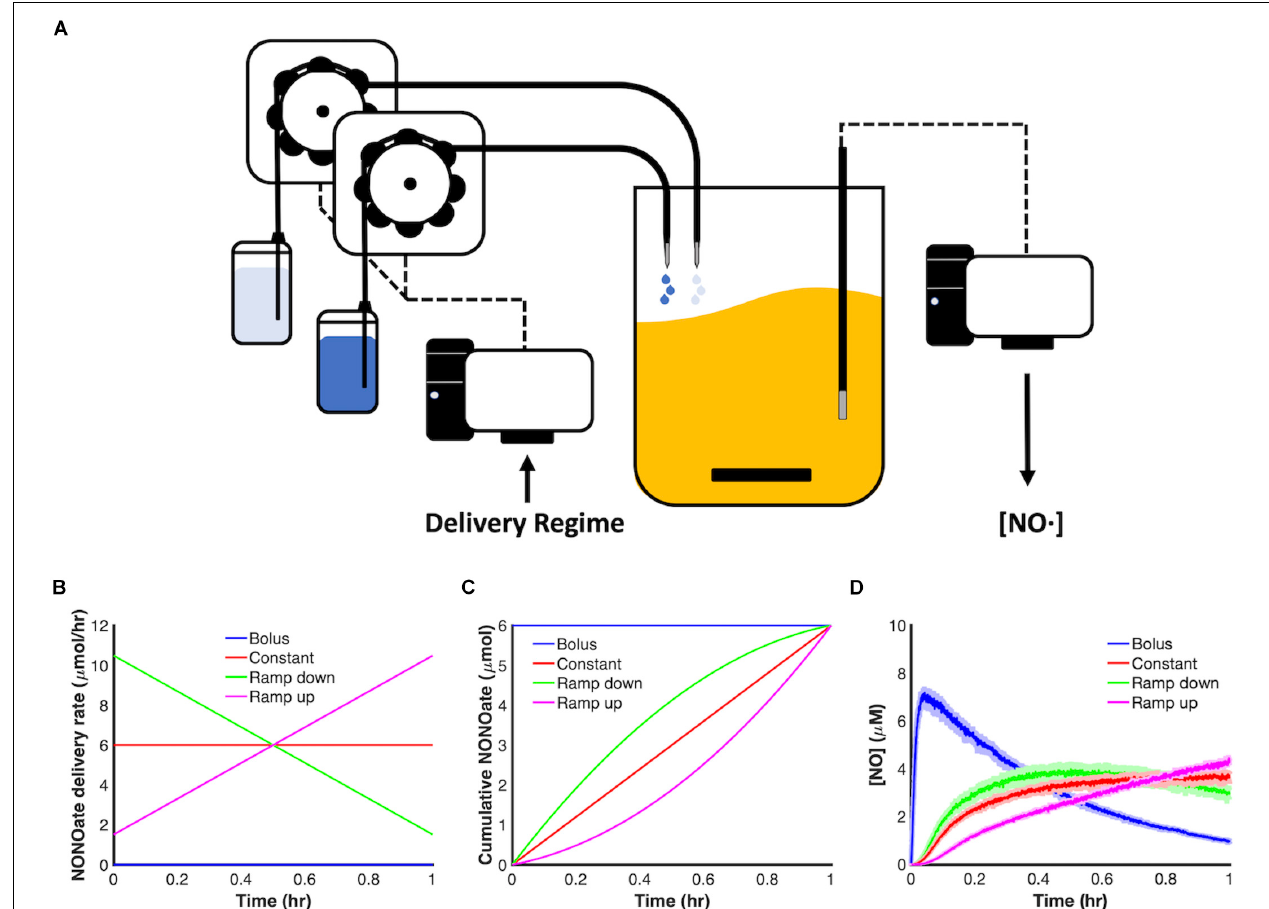
FIGURE 1 | Control of NONOate delivery dynamics. (A) Schematic of a computer-controlled, fed-batch bioreactor used to deliver NONOate. Delivery schedules were programmed using a computer-controlled low flow drip system. Once initiated, individual peristaltic pumps drew solutions from two reservoirs: PAPA NONOate solution (dark blue) and 10 mM NaOH (light blue), which then dripped into a bioreactor containing 50 mL MOPS minimal media. [NO] was continuously measured in the bioreactor using an electrochemical probe. (B,C) 6 µ mol PAPA NONOate was delivered over an hour in four modes: bolus (blue), constant (red), ramp down (green), ramp up (pink). (D) Measured [NO] dynamics, for each mode, during delivery of 6 µ mol PAPA NONOate over an hour in the absence of cells. Solid lines represent the mean of three replicates, whereas the lightly shaded areas represent the standard error of the